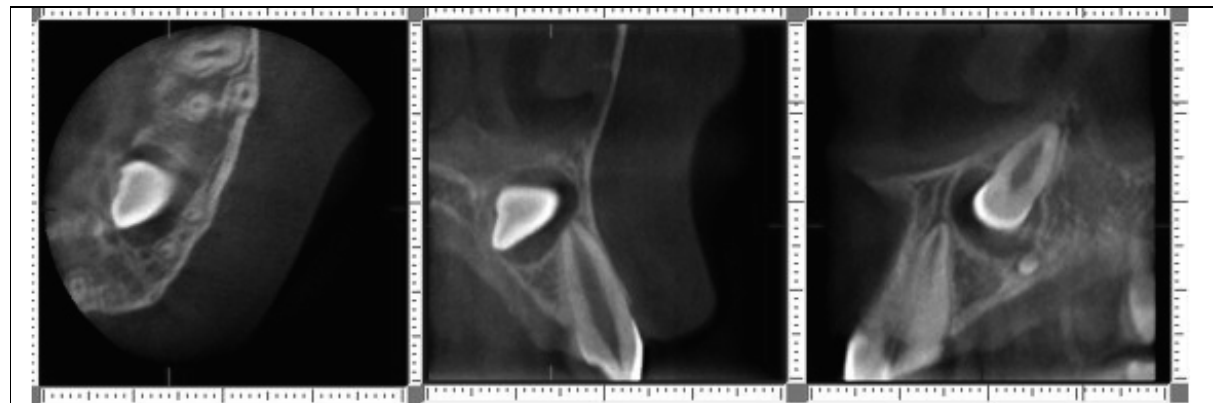
Figure 1. (A) Axial; (B) sagittal; (C) coronal views of a patient with impaction resorption of the upper left permanent lateral incisor tooth due to impacted upper left permanent canine tooth; the apical third of the palatal surface has been resorbed to a slight degree (grade 2).